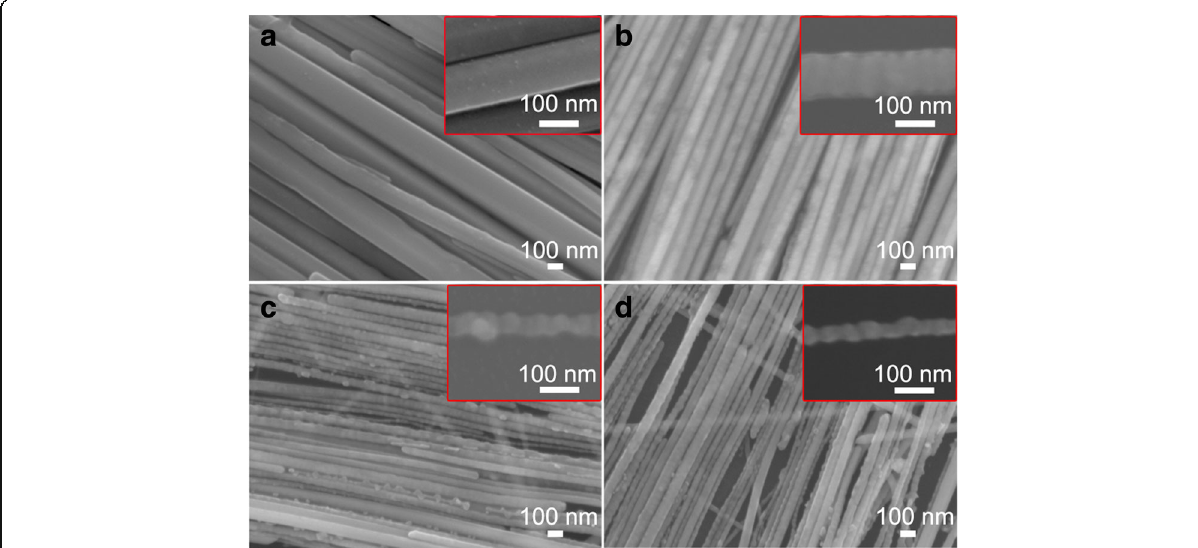
Fig. 2 SEM images of self-assembled as-synthesized ( a ) and etched Ag nanowire film on the surface of silicon wafers using 200 μ L ( b ), 300 μ L ( c ),